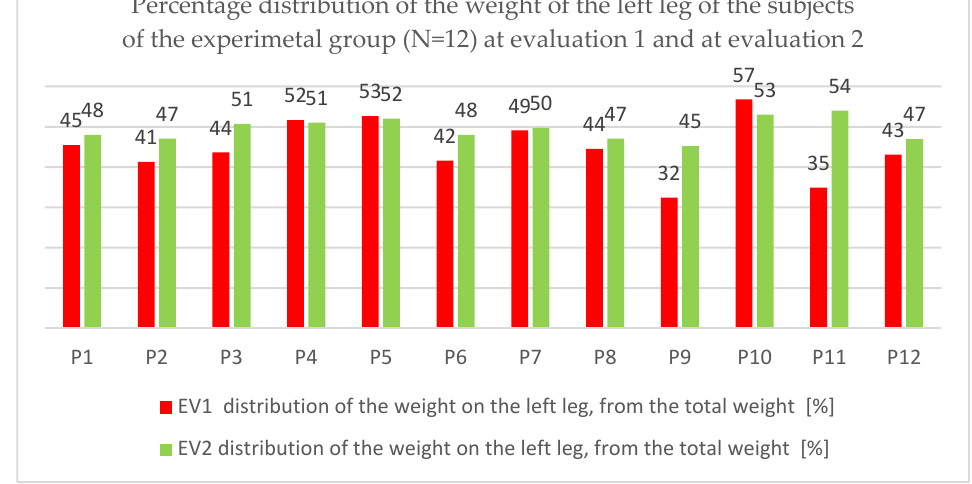
Figure 12. Percentage distribution of the weight on the left leg, from the total weight at the first and second evaluation of the subjects of the experimental group (N = 12).